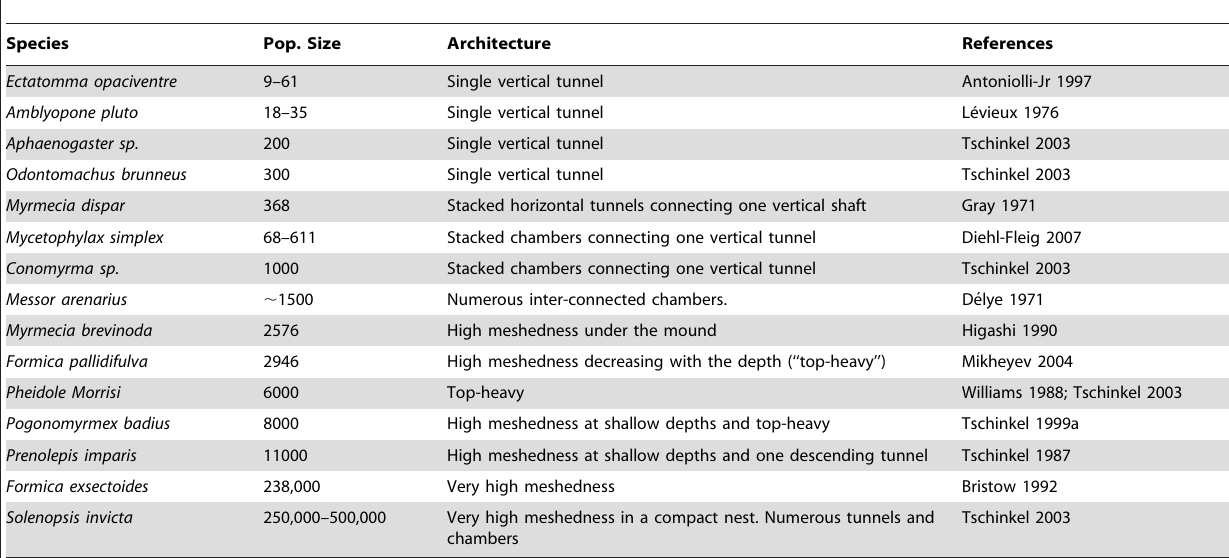
Table 1. The relationship between meshedness and colony size in